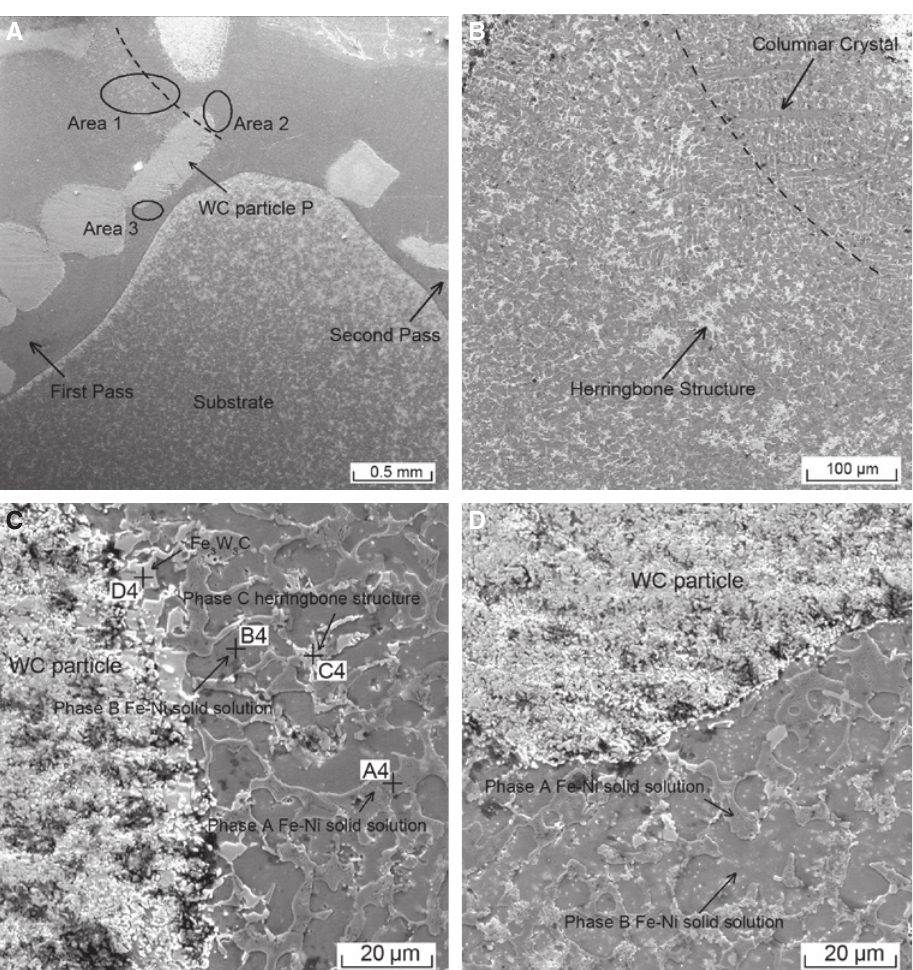
Figure 7: Microstructures of the multipass specimen: (A) overview of the overlapping area of the first and second passes, (B) local enlarge- ment of area 1 in (A), (C) local enlargement of area 2 in (A), and (D) local enlargement of area 3 in (A).